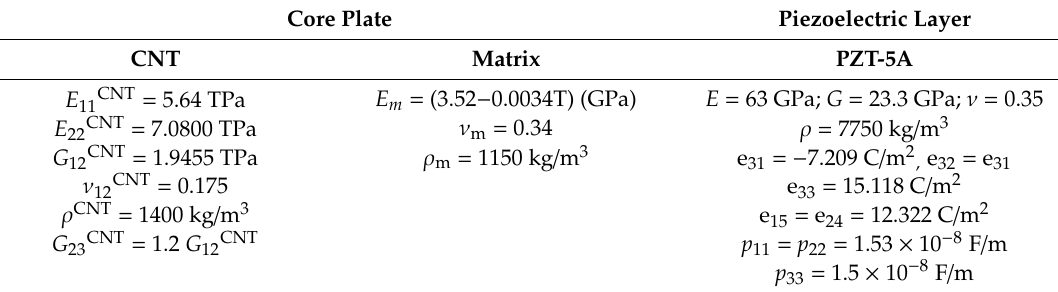
Table 5. Values of material parameters.